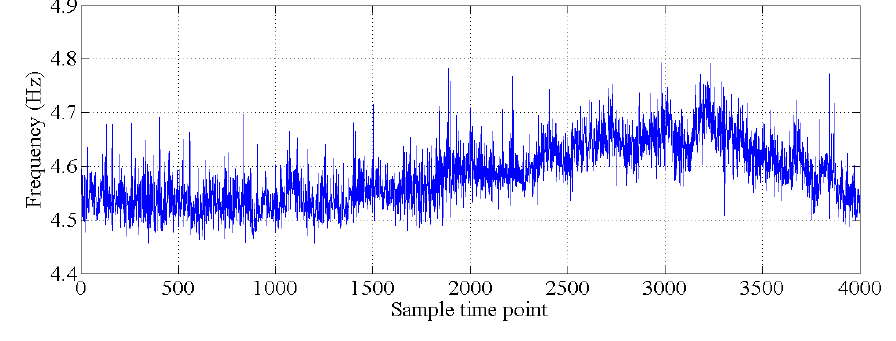
Figure 14. Arrangement of acceleration sensors (unit: m).